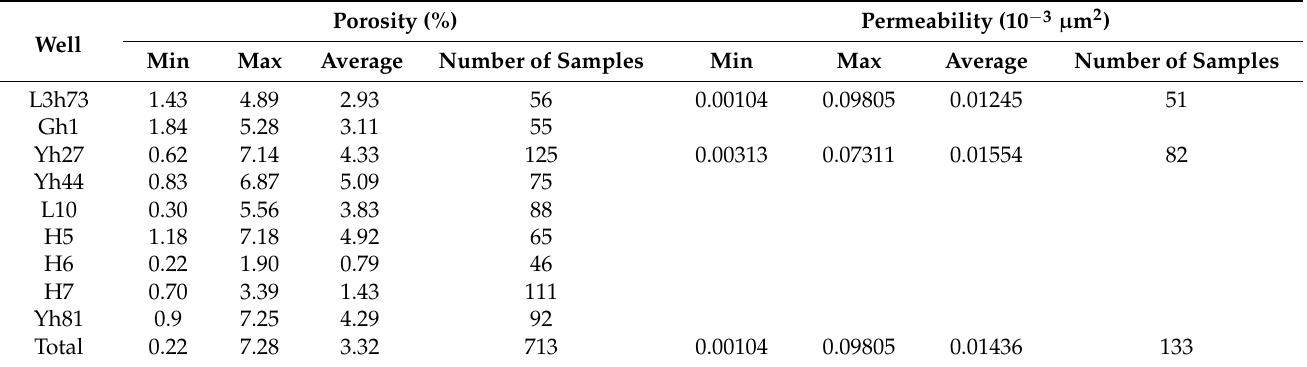
Table 5. Statistical table of porosity and permeability of shale in the Longmaxi Formation in the study